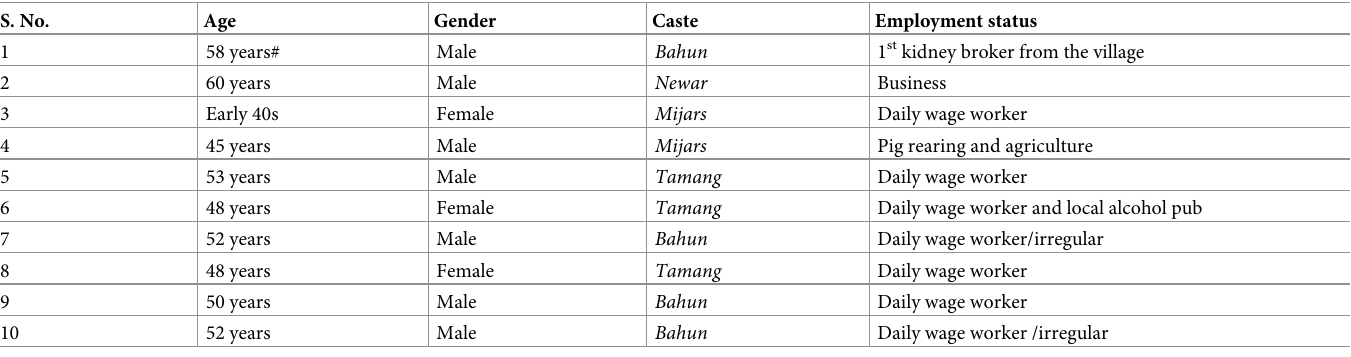
Table 2. General characteristics of kidney